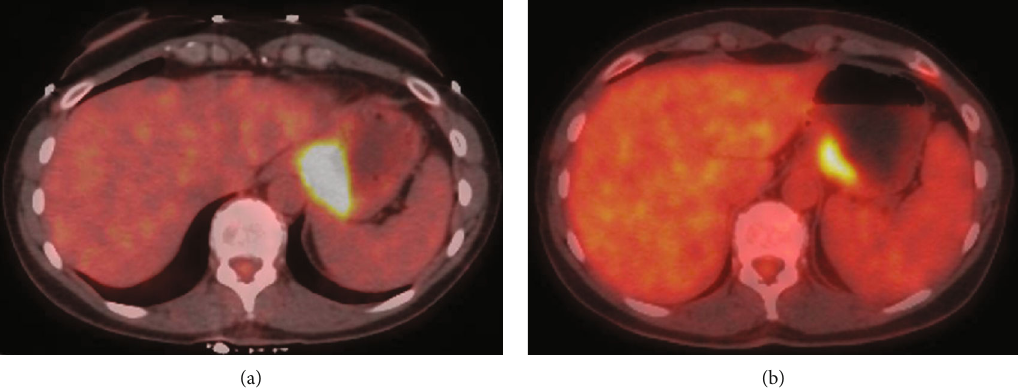
Figure 3: Initial axial fused PET/CT image (a) showing robust hypermetabolism of the gastric cardia (max SUV 10.4) with subsequent axial fused PET/CT image (b.) following neoadjuvant therapy with reduced size and uptake (SUV 4.3), consistent with 60% reduction in FDG